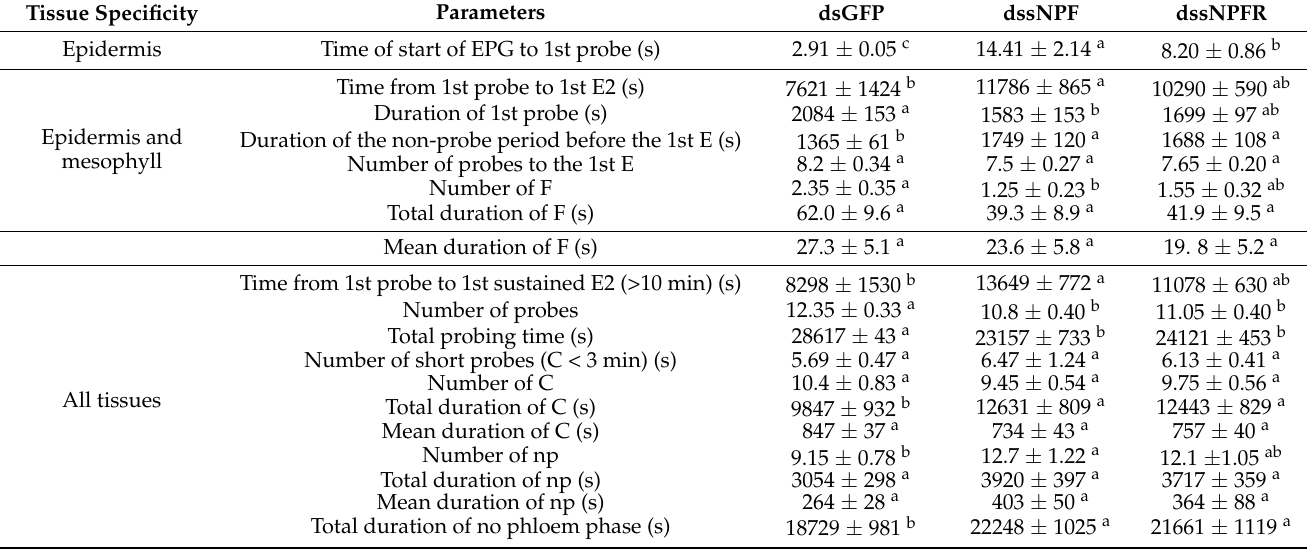
Abbreviations used in the second column: s (seconds). Results are shown as mean ± SE. Different lowercase letters in the same row indicate significant difference at p < 0.05 level by LSD